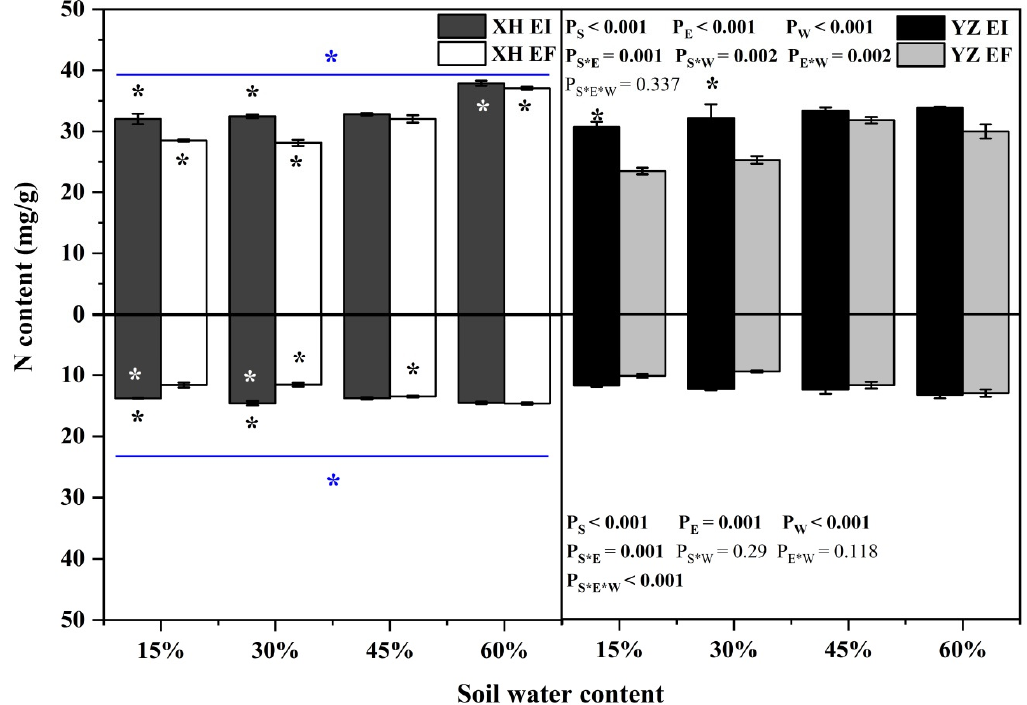
Figure 8. The N content of A. inebrians seedlings shoots and roots from XH(W) and YZ(D) seeds under various soil water content (mg/g). Upwards and downwards bars represent the value of shoot and root part, respectively. The asterisk (*) above/below error bars means significant differ- ence ( p < 0.05) between EI and EF under the same soil water content. White/black * in the dark gray/white bars indicates significant difference ( p < 0.05) between Xiahe and Yuzhong maternal habitat type of EF/EI grasses. The blue * above/below full blue line indicates significant difference ( p < 0.05) between Xiahe and Yuzhong maternal habitat type.